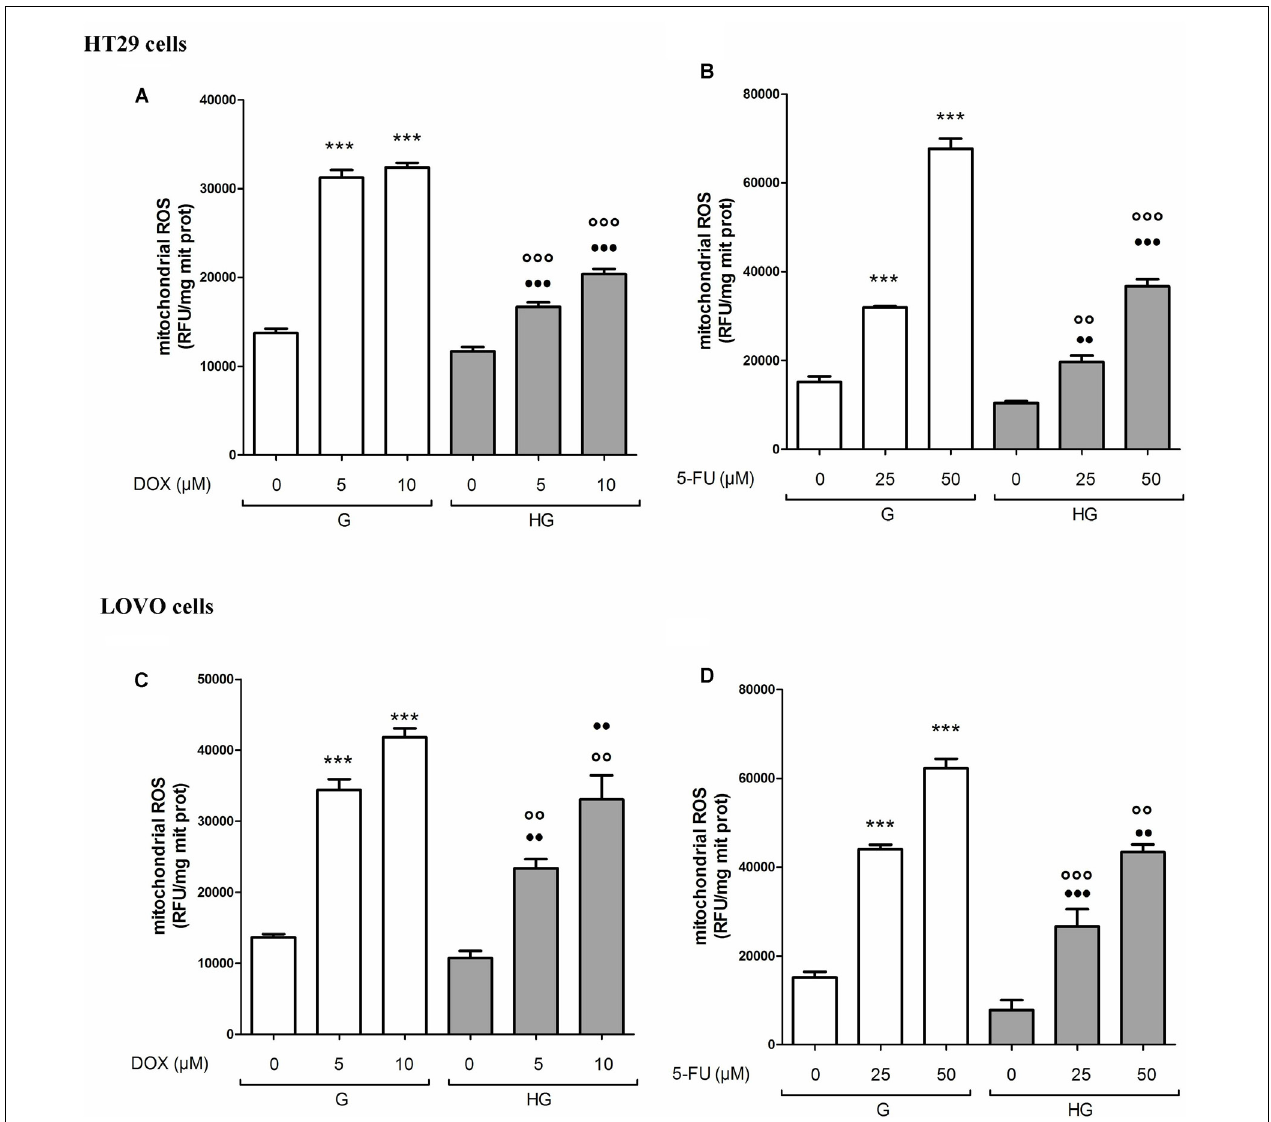
FIGURE 3 | Effect of normal glucose (G) and high glucose (HG) on mitochondrial ROS production in absence or presence of DOX (A,C) or 5-FU (B,D) in human colon cancer (HT29 and LOVO) cells. Cells were cultured for ≥ 7 days in the presence of G and HG, incubated for 24 h before analysis with 5 and 10 µ M DOX or 25 and 50 µ M 5-FU and then the mitochondrial ROS levels were measured fluorimetrically in triplicate using the DCFDA-AM probe. Measurements ( n = 8) were performed in duplicate. (A) ∗∗∗ p < 0.0001 5 and 10 µ M DOX in HT29 cells cultured in G vs. 0 µ M DOX in HT29 cells cultured in G; ◦◦◦ p < 0.0001 5 and 10 µ M DOX in HT29 cells cultured in HG vs. 5 and 10 µ M DOX in HT29 cells cultured in G; ••• p < 0.0001 5 and 10 µ M DOX in HT29 cells cultured in HG vs. 0 µ M DOX in HT29 cells cultured in HG. (B) ∗∗∗ p < 0.0001 25 and 50 µ M 5-FU in HT29 cells cultured in G vs. 0 µ M 5-FU in HT29 cells cultured in G; ◦◦ p < 0.001 25 and ◦◦◦ p < 0.0001 50 µ M 5-FU in HT29 cells cultured in HG vs. 25 and 50 µ M 5-FU in HT29 cells cultured in G; •• p < 0.001 25 and ••• p < 0.0001 50 µ M 5-FU in HT29 cells cultured in HG vs. 0 µ M 5-FU in HT29 cells cultured in HG. (C) ∗∗∗ p < 0.0001 5 and 10 µ M DOX in LOVO cells cultured in G vs. 0 µ M DOX in HT29 cells cultured in G; ◦◦ p < 0.001 5 and 10 µ M DOX in HT29 cells cultured in HG vs. 5 and 10 µ M DOX in LOVO cells cultured in G; •• p < 0.001 5 and 10 µ M DOX in LOVO cells cultured in HG vs. 0 µ M DOX in HT29 cells cultured in HG. (D) ∗∗∗ p < 0.0001 25 and 50 µ M 5-FU in LOVO cells cultured in G vs. 0 µ M 5-FU in LOVO cells cultured in G; ◦◦◦ p < 0.0001 25 and ◦◦ p < 0.001 50 µ M 5-FU in LOVO cells cultured in HG vs. 25 and 50 µ M 5-FU in LOVO cells cultured in G; ••• p < 0.0001 25 and •• p < 0.001 50 µ M 5-FU in LOVO cells cultured in HG vs. 0 µ M 5-FU in LOVO cells cultured in HG.